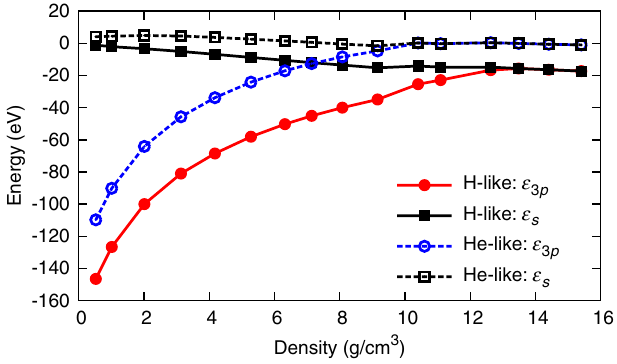
FIG. 9. The muffin-tin flat potential ( ε s ) and 3 p orbital energy ( ε 3 p ) of H-like and He-like Al as a function of the solid density at T ¼ 700